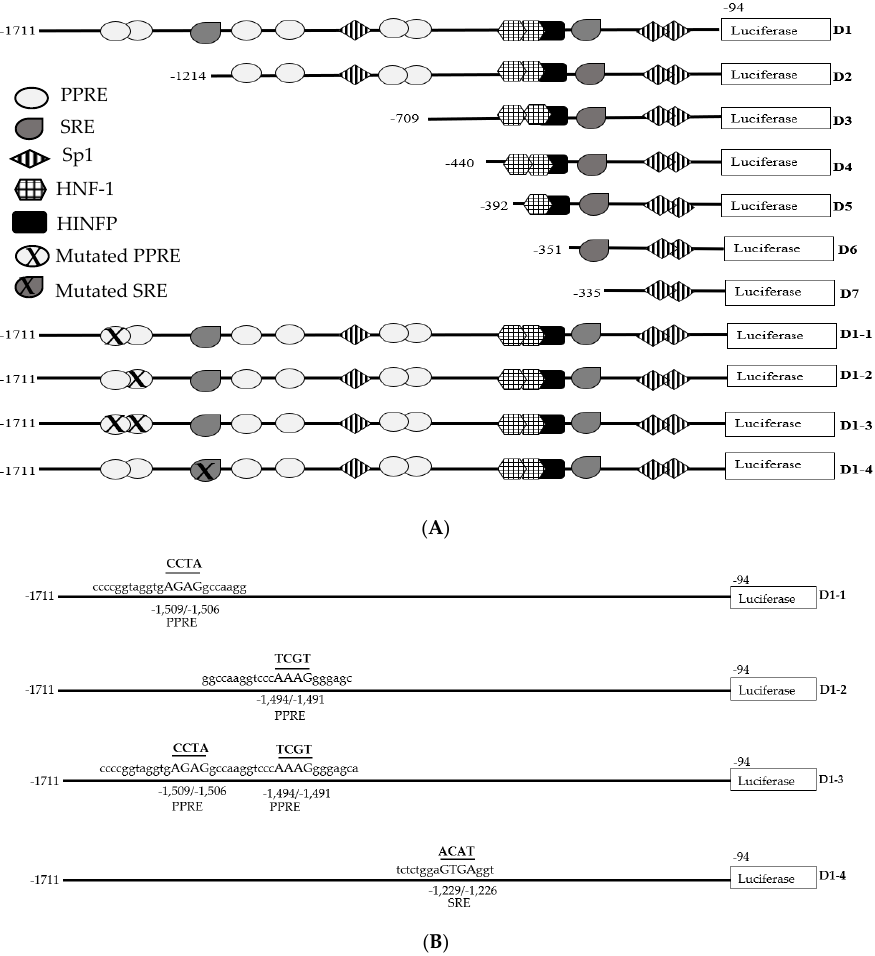
Figure 6. Identification of cis-acting elements involved in the downregulatory effects of the selected A. planci fraction on PCSK9 expression. ( A ) Schematic representation of the predicted potential transcription binding sites on the 5′ -end-deletion constructs of human PCSK9 promoter, as well as the mutated PPRE and SRE used in this study. Position −94 is the 3′ end of PCSK9 promoter inserts common to all promoter –reporter constructs. The 5′ ends of the promoter in each construct are marked by the numbers on the left. MatInspector software was used to predict the transcription binding sites on the PCSK9 promoter (PPRE, peroxisome proliferator response element; SRE, sterol regulatory element; Sp1, specificity protein 1; HNF-1, hepatocyte nuclear factor 1; HINFP, histone nuclear factor P). ( B ) The core nucleotides for the predicted PPRE and SRE on the PCSK9 promoter are presented in capital letters, and the mutated nucleotides within the binding sites are in capital letters, underlined, and highlighted in bold.